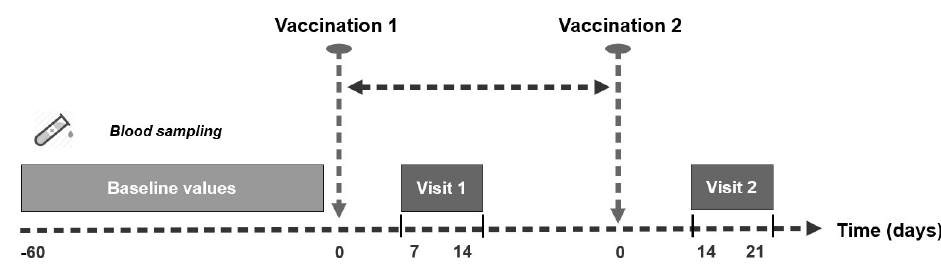
Figure 1. Vaccination administration schedule according to the Austrian Vaccination Policy.